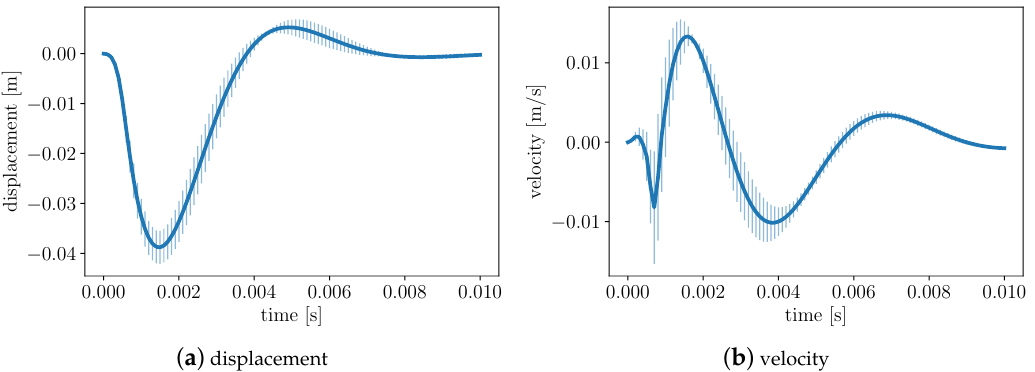
Figure 11. The Polynomial Chaos (PC) prediction of the displacement and velocity at the mid-span. The uncertainty bounds represent two standard deviation.